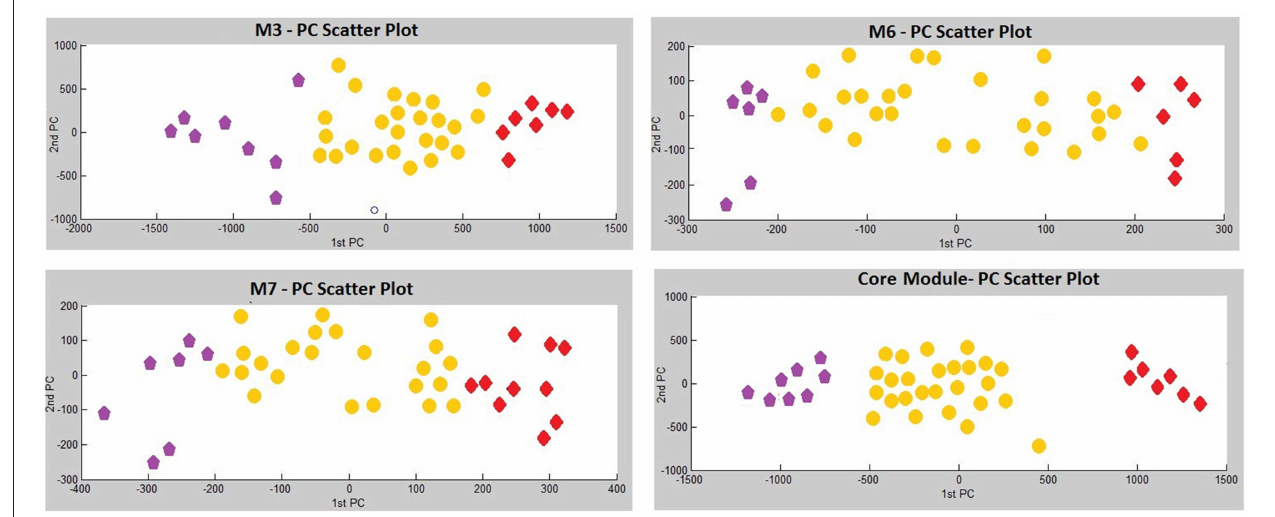
FIGURE 4 | Principle Components Analysis (PCA) plots of differentially co-expressed gene modules (M3, M6, M7, and core module) that have significant prognostic performance.